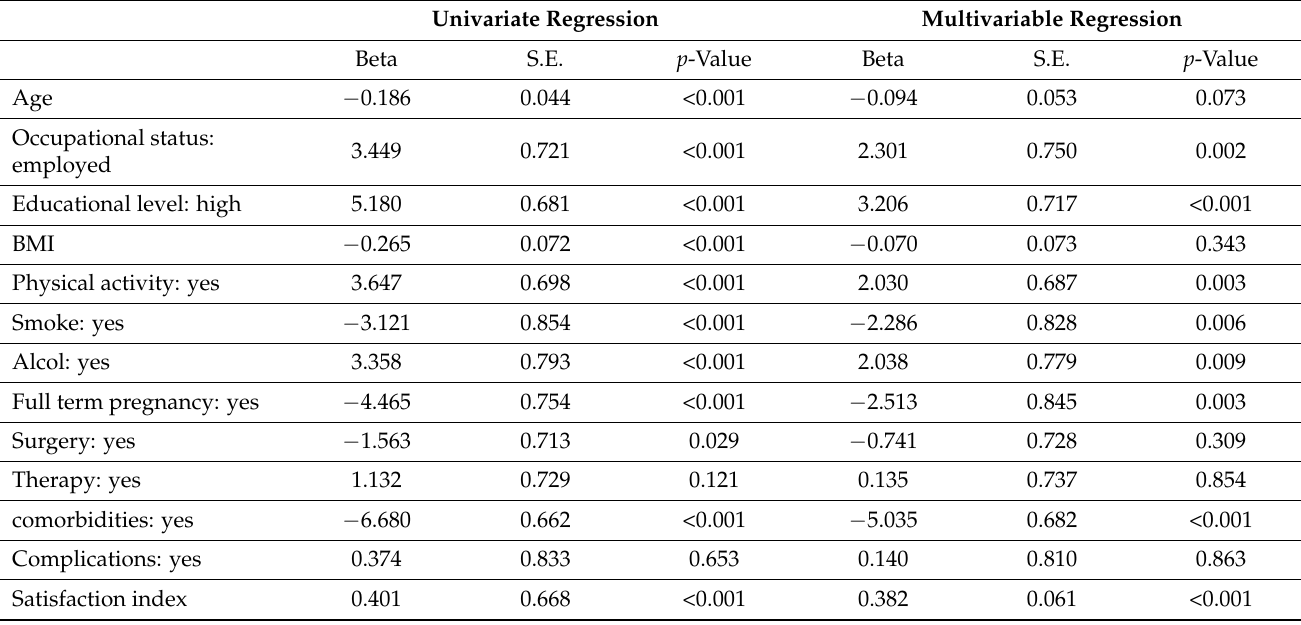
Table 4. Predictors of high level of PCS ( n = 875